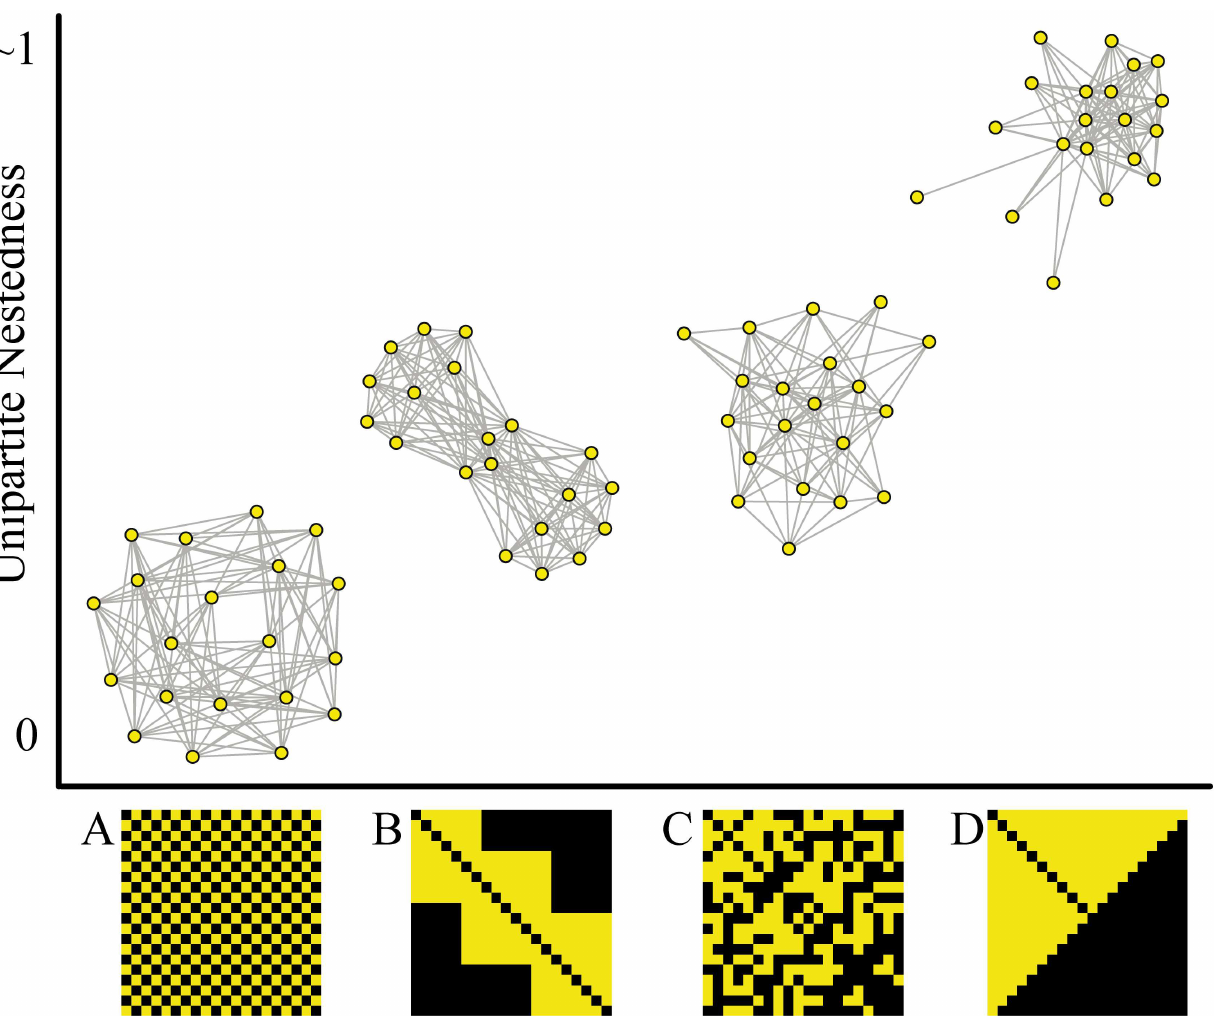
Fig 1. Nestedness of hypothetical undirected one-mode networks. Nestedness is zero when links are evenly distributedamongnodes (A, checkerboard pattern), intermediate when links are clustered in distinct subsets of nodes (B, modular) or randomly distributed (C, random), and maximum when nodeswith fewer interactions (peripheralnodes)interact with proper subsets of the subset of thighly connectednodes(D, perfectly nested). Networks have the same size (number of nodes) and connectance (proportionof realizedlinks) and are followedby their binary adjacencymatrices (symmetric and squaredmatrices, with yellow cells denotinglink presence betweennodes).